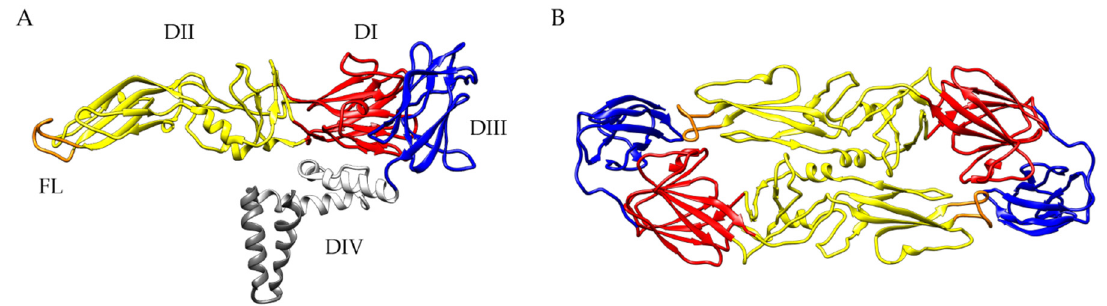
Figure 1. The structure of the TBEV E protein (PDB-ID 5O6A [5]). ( A ) Side view of a single TBEV E protein monomer. Depicted are the four domains (DI: red, DII: yellow, DIII: blue, DIV (stem/anchor): gray) and the fusion loop (FL: orange). ( B ) Top view of a soluble TBEV E protein dimer. Color code same as in ( A ). Ribbon diagrams were prepared with UCSF Chimera [110].